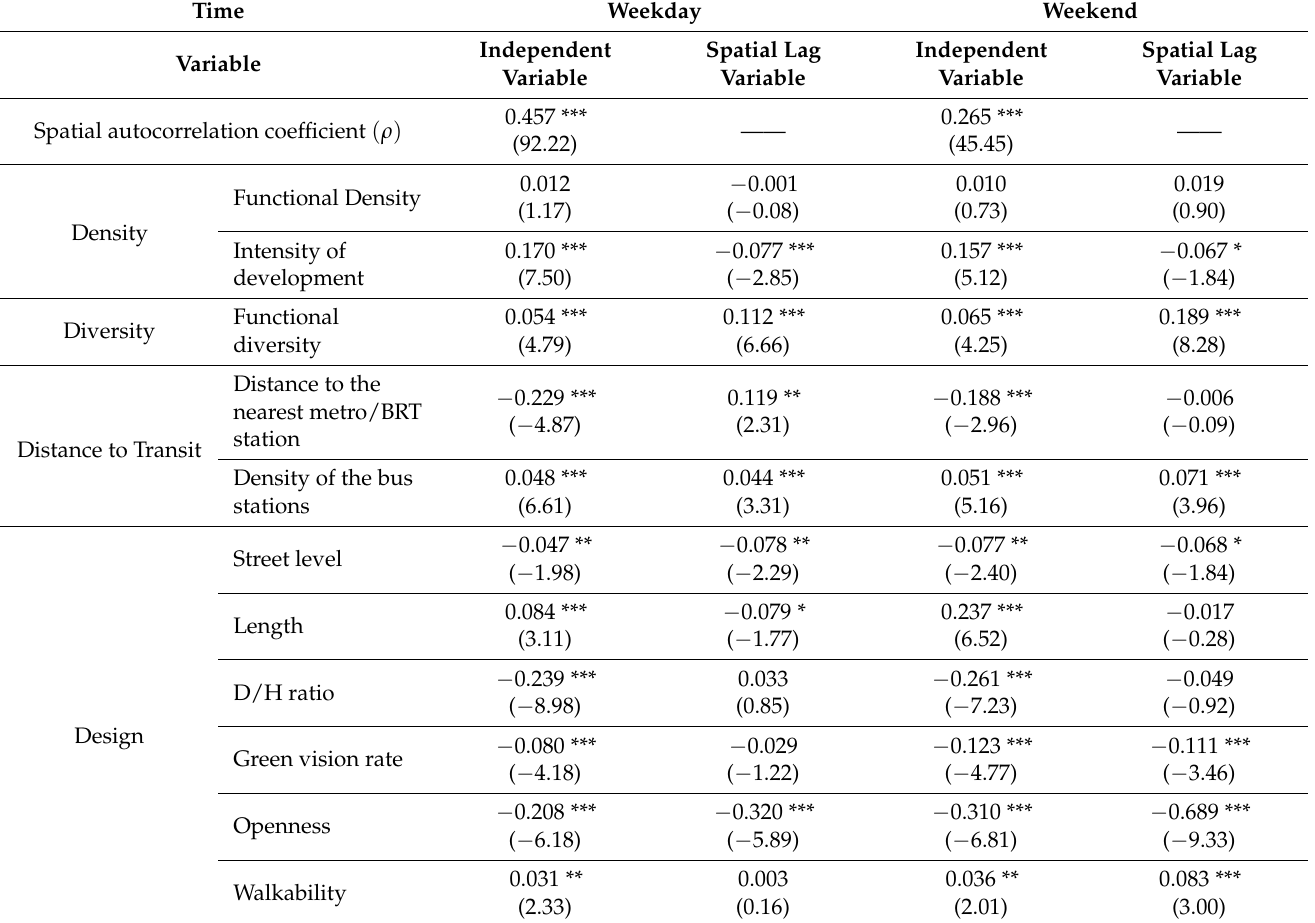
Table 3. Estimated results of the spatial panel Durbin